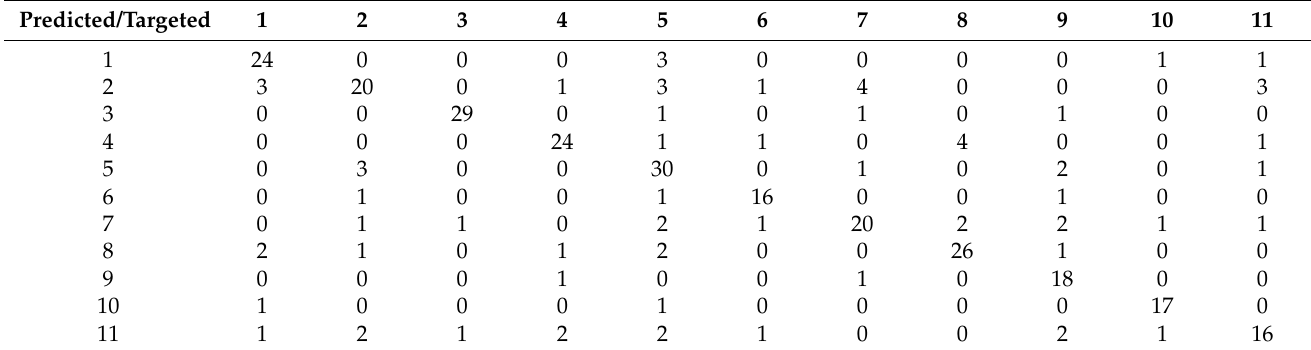
Table 1. The confusion matrix for UCF YouTube Action